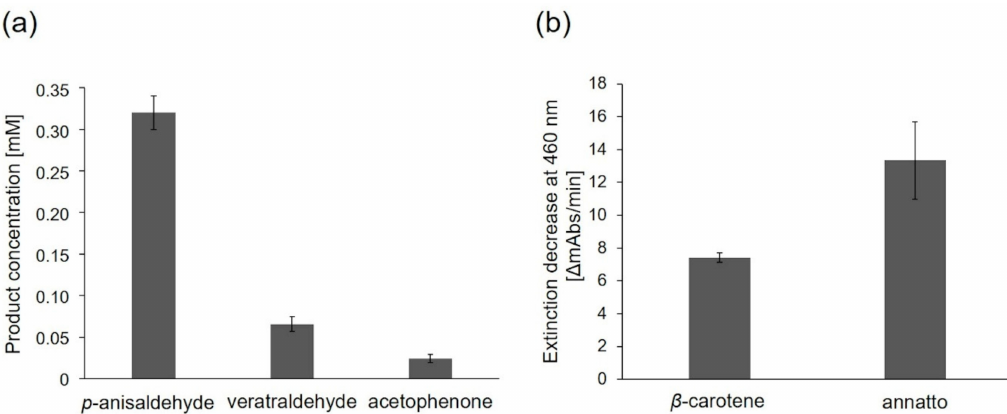
Figure 7. Alkene cleavage activity of PsaPOX on di ff erent substrates in the presence of 100 µ M H 2 O 2 and 25 mM MnSO 4 at pH 3.5. ( a ) Product concentration after conversion of trans -anethole (6.7 mM) to p -anisaldehyde, ( E )-methyl isoeugenol (6.7 mM) to veratraldehyde, and α -methylstyrene (6.7 mM) to acetophenone by PsaPOX (1 U / mL) at RT. The presented product concentrations are the di ff erences between the values determined for the reaction with the active and heat inactivated enzyme (blank) (the original values are shown in Table S4). ( b ) Decolorization of 7% ( v / v ) β -carotene and 7% ( v / v ) annatto by PsaPOX (1 U / L) at 40 ◦ C. Cleavage of carotenoids was shown as extinction decrease per min. Values are the average of triplicate experiments with standard deviations shown as error